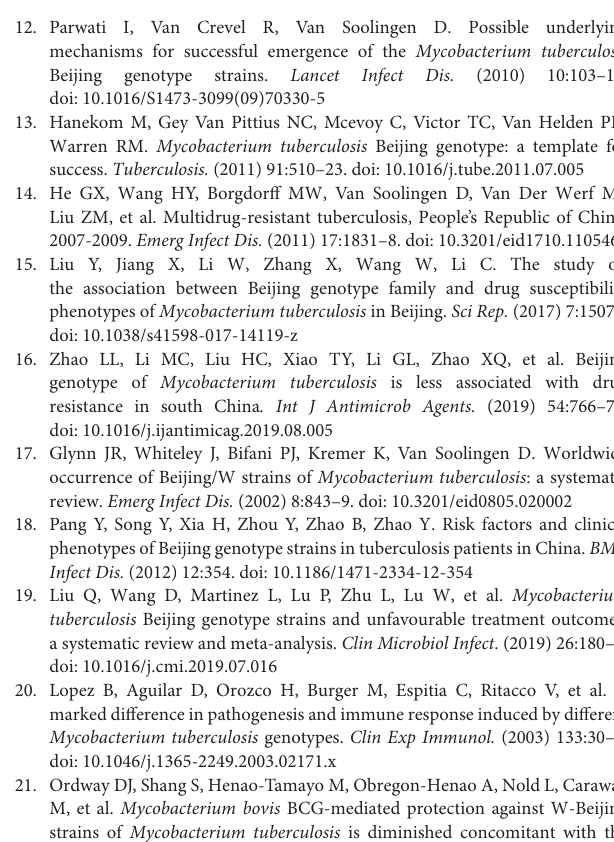
form of pneumonia (arrows). Stained with haematoxylin and eosin (Black bar in the first image corresponds to 500 µ m). Supplementary Figure 5 | Representative histological images from lungs of animals infected with strains 48, 48P, 48V, and 48S and euthanized on days 14, 21, and 28 post-infection. Lungs from animals infected with the original-stock strain 48 show interstitial, peribronchial, and perivascular inflammation ( ∗ ) by day 14 post-infection. Contrary, lungs from animals infected by strain 48V show very scarce if any inflammatory infiltrate on day 14 post-infection. Lungs from animals which were infected by strain 48V and euthanized on day 21 post-infection show pneumonic and necrotic areas (arrows), in comparison with those infected by strain 48 on this same time-point, which show mostly pneumonia (dotted arrow), with very scarce or null necrosis. Stained with hematoxyylin and eosin (black bar in the first image corresponds to 500 µ m). Supplementary Figure 6 | Representative granuloma from a subject infected by original stock strain 46, and sacrificed at day 7 postinfection. Stained with hematoxylin and eosin, 100X magnification. Supplementary Table 1 | Genome assembly